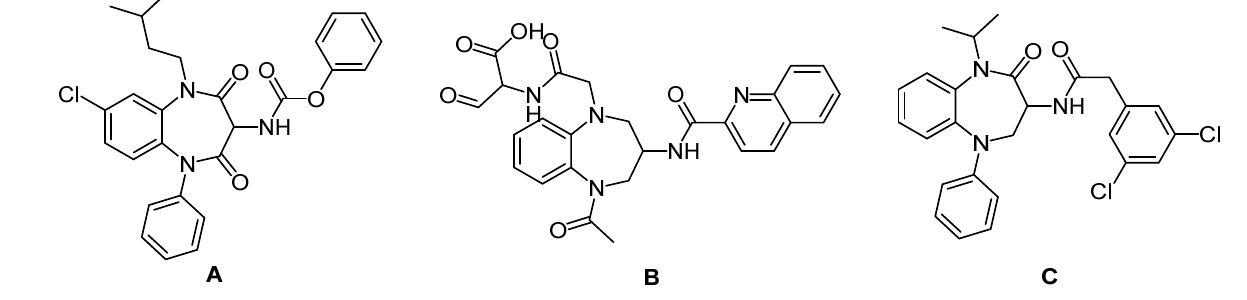
Figure 1. Polycyclic BZD derivatives A , B , and C .